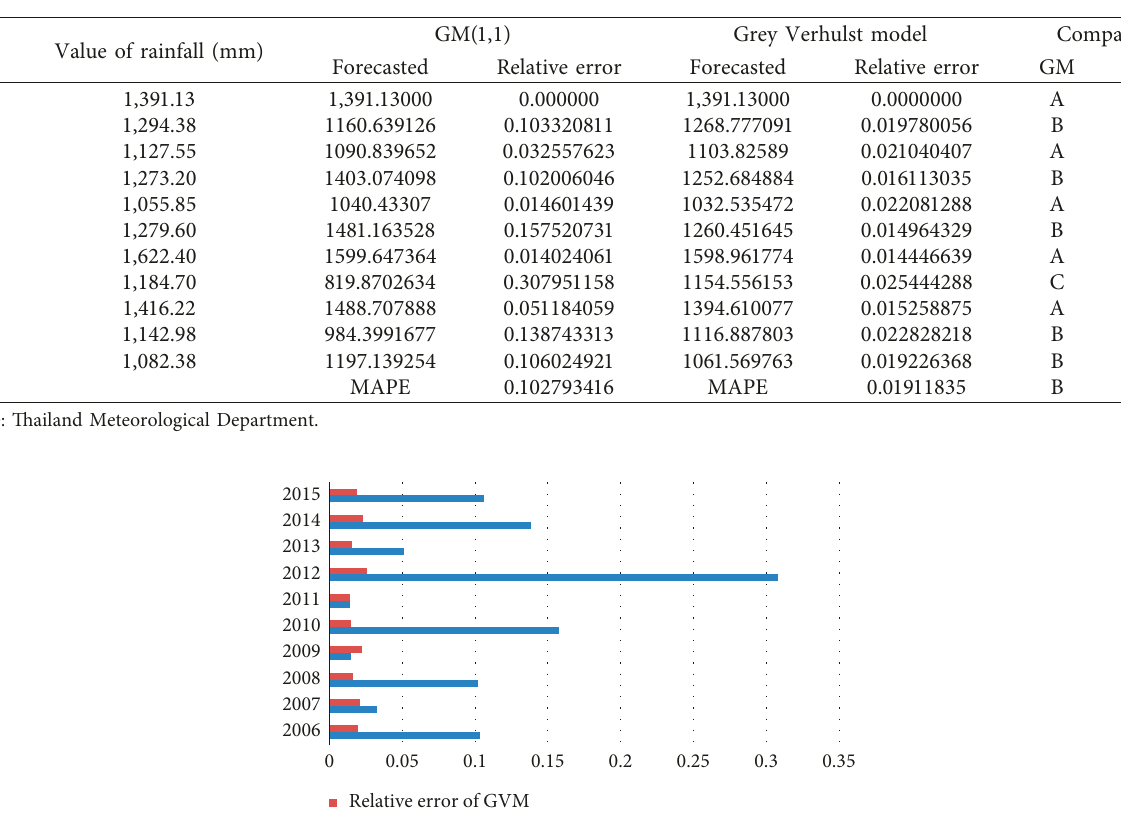
Table 2: The simulation value of rainfall and relative error from actual data of the two models.